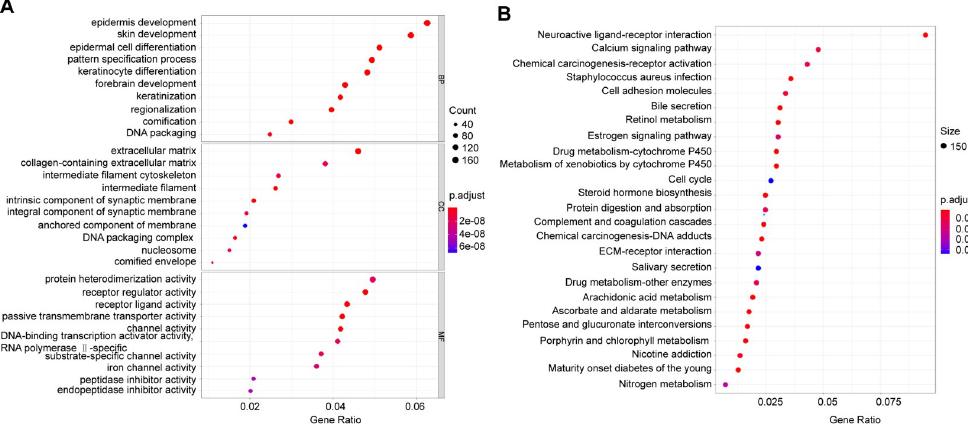
Fig 7. GO analyze and KEGG pathway. A. BP: biochemical process, CC: cell component, MF: molecular function, the abscissa is enriched to this term. The number of different genes, p < 0.05.